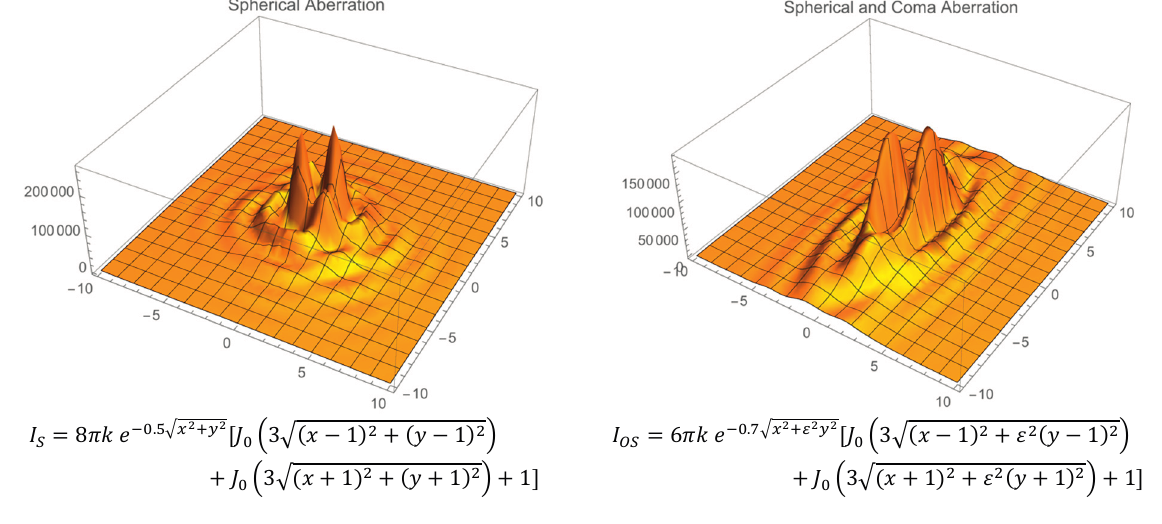
Figure 8. The intensity profiles are plotted using equations that simulate the spherical and spherical with coma aberrations at the optical caustic focal length [20,30]. In the right panel, the parameter ɛ is the eccentricity of the oblate spheroid, and as in Figure 4, k is the angular wavenumber.